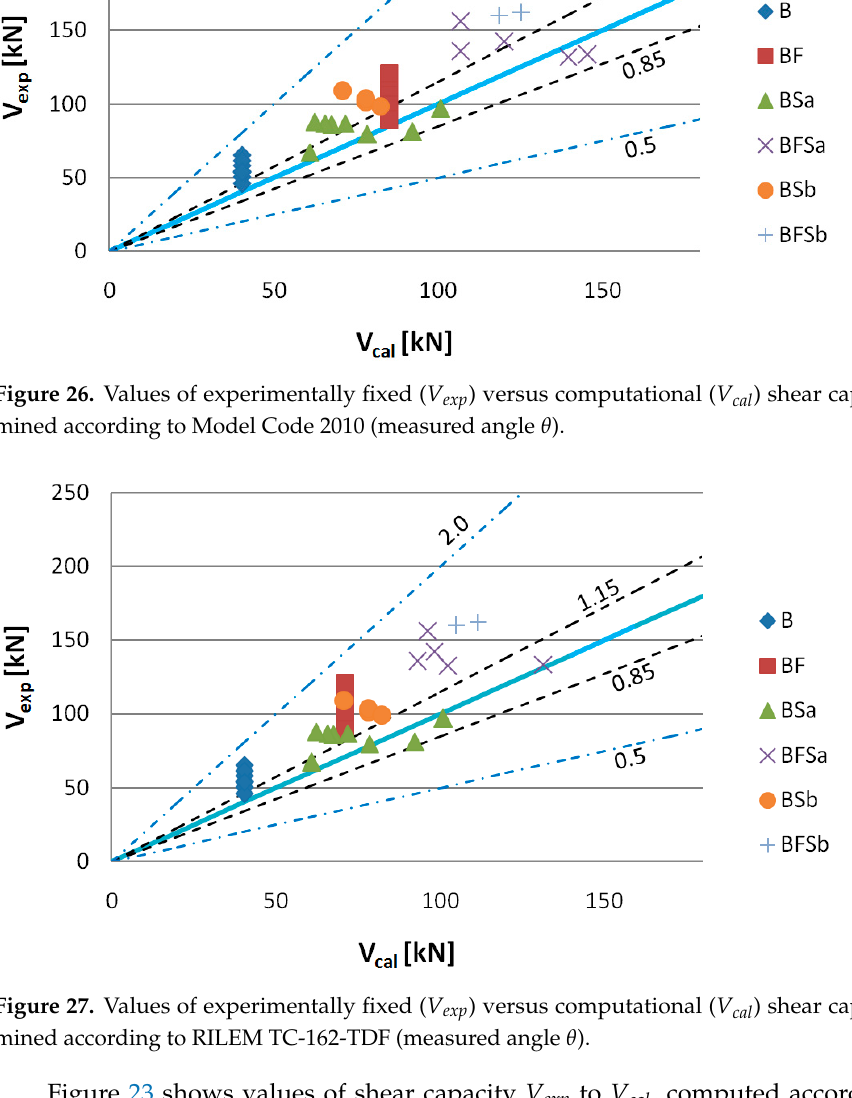
Figure 27. Values of experimentally fixed ( V exp ) versus computational ( V cal ) shear capacity deter- mined according to RILEM TC-162-TDF (measured angle θ ).